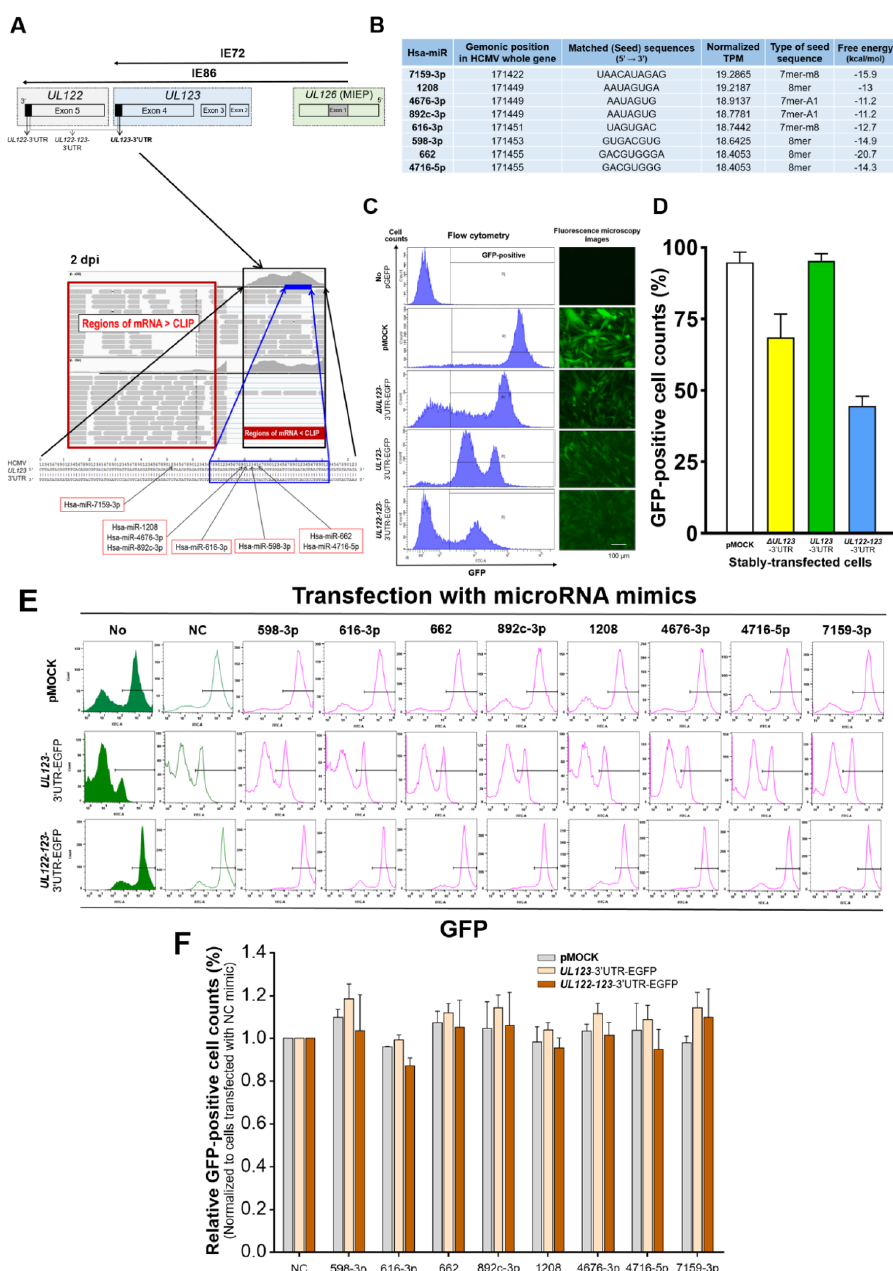
Figure 1. Establishment of U373MG cells stably-transfected with the 3 (cid:48) -UTR and verification of the binding of candidate miRNAs − predicted using AGO-CLIP-seq − to the 3 (cid:48) -UTR of UL123 . ( A )